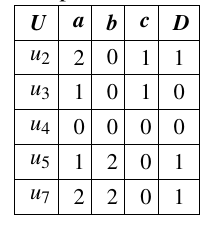
Table 2 Compressed decision table.